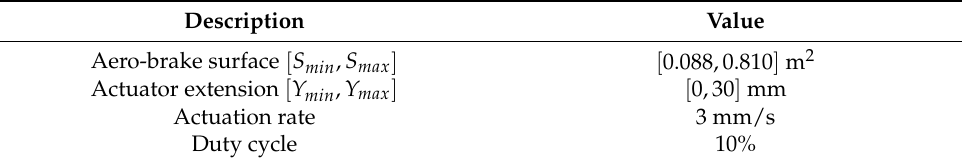
Table 3. Deployable aero-brake system